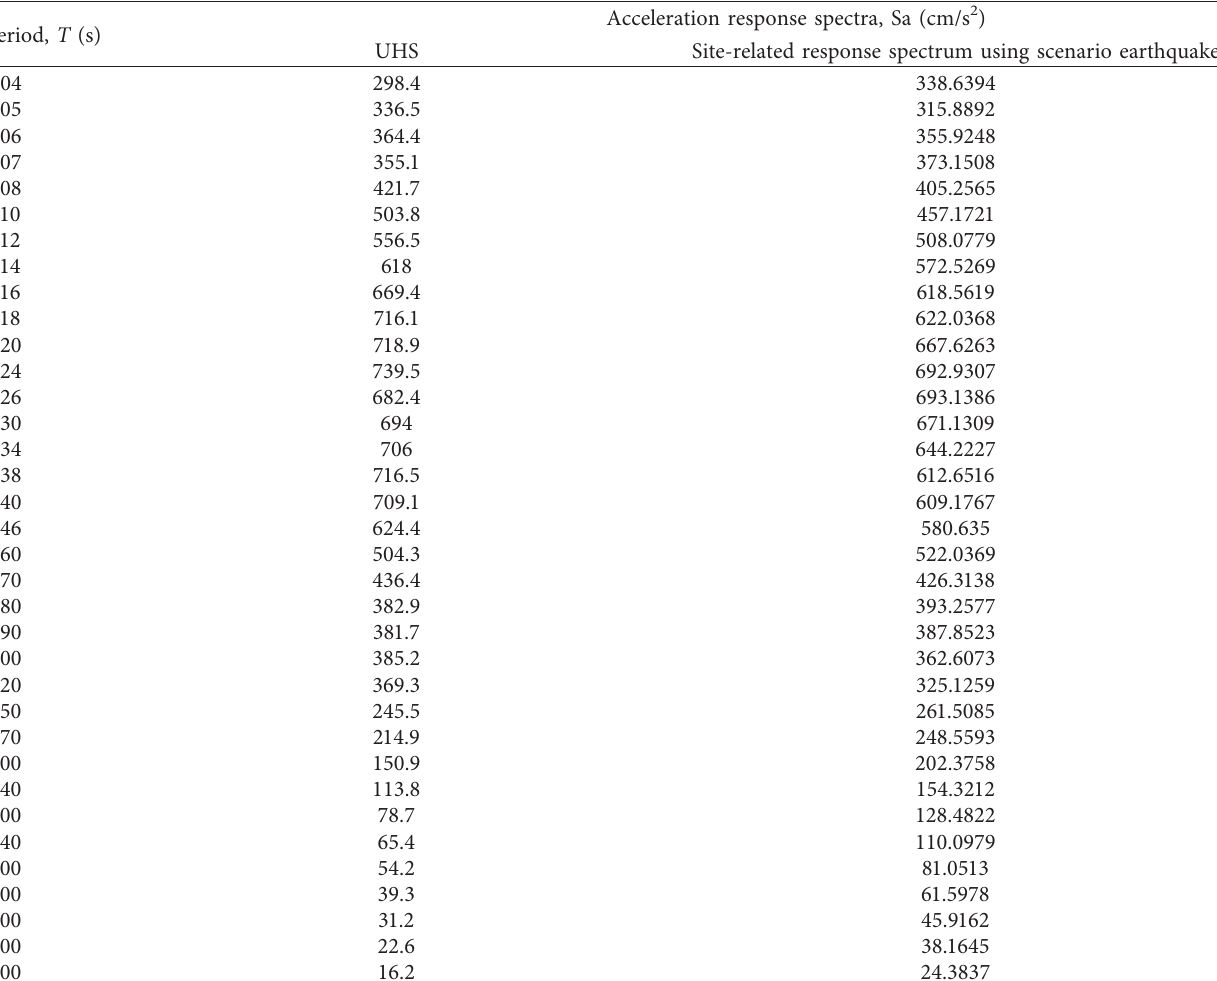
Figure 2: Comparisons of UHS and site-related response spectrum based on scenario earthquake. Table 1: Response spectra shown in Figure